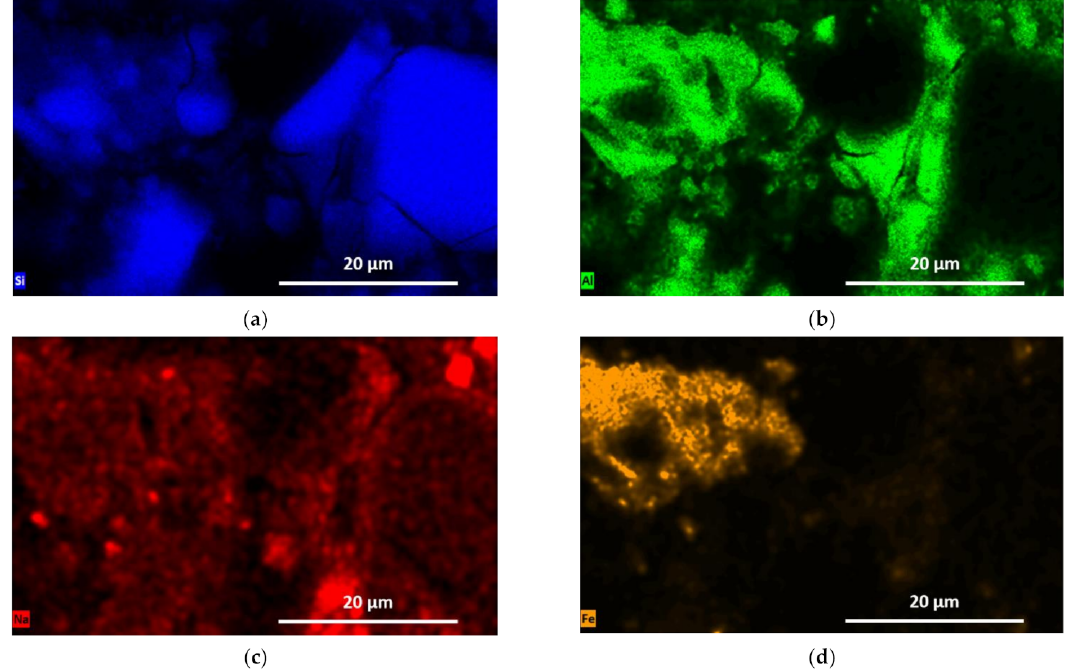
Figure 3. Elemental maps of the major elements in spent pot lining aluminosilicates obtained from energy dispersive X-ray spectroscopy measurements: ( a ) Si, ( b ) Al, ( c ) Na and ( d ) Fe. Note that these measurements were performed on image ( b ) in Figure